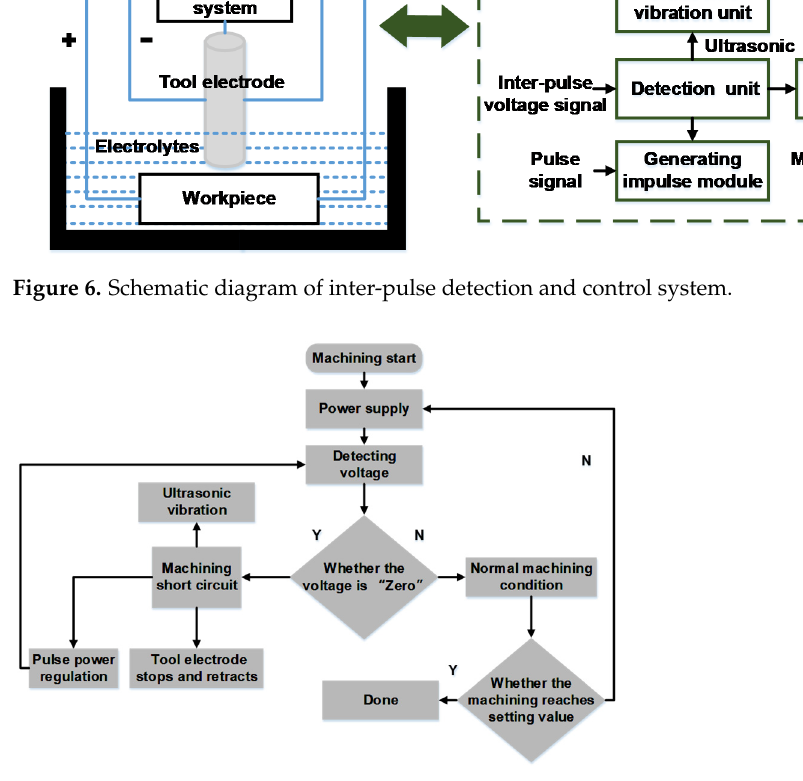
Figure 7. Detection, feedback, and control flowchart.